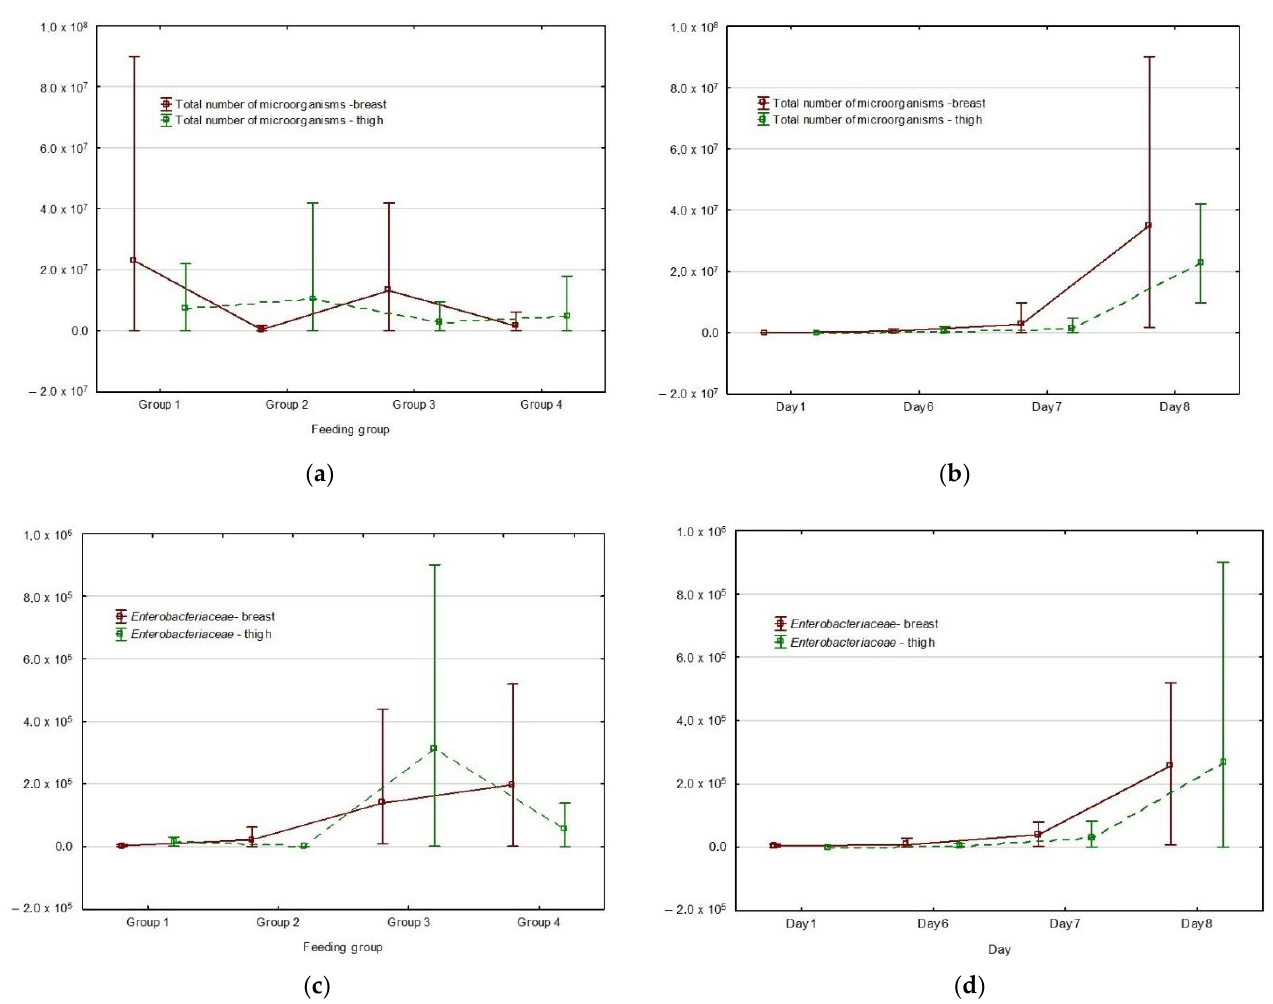
Figure 1. Mean plot of multiple variables grouped by day and feeding group; vertical lines show the nonoutlier range: ( a ) total number of microorganisms in the breast and thigh muscles relative to feeding groups; ( b ) total number of microorganisms in the breast and thigh muscles relative to day of the experiment; ( c ) Enterobacteriaceae in the breast and thigh muscles relative to feeding groups; ( d ) Enterobacteriaceae in the breast and thigh muscles relative to day of the experiment.